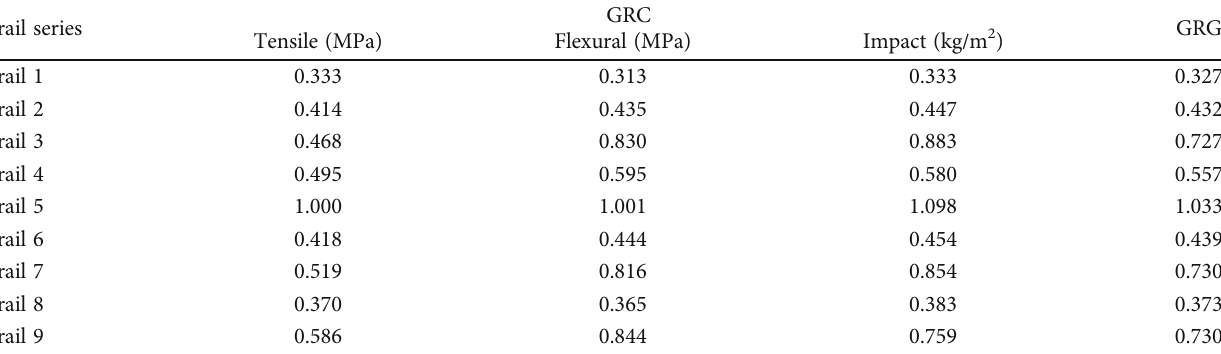
Table 5: GRC and GRG of the composites.